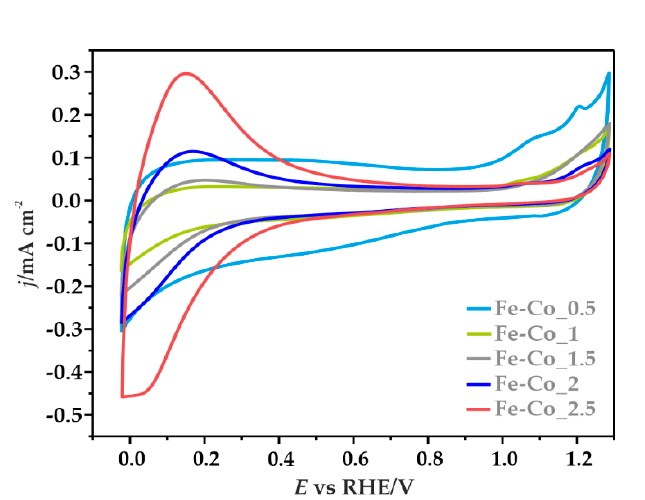
Figure 7. CV profiles for the Fe-Co oxide active phase deposited on the N,S-MPC, recorded in Ar-saturated 0.1 M KOH solution at the scan rate of 10 mV s − 1 .